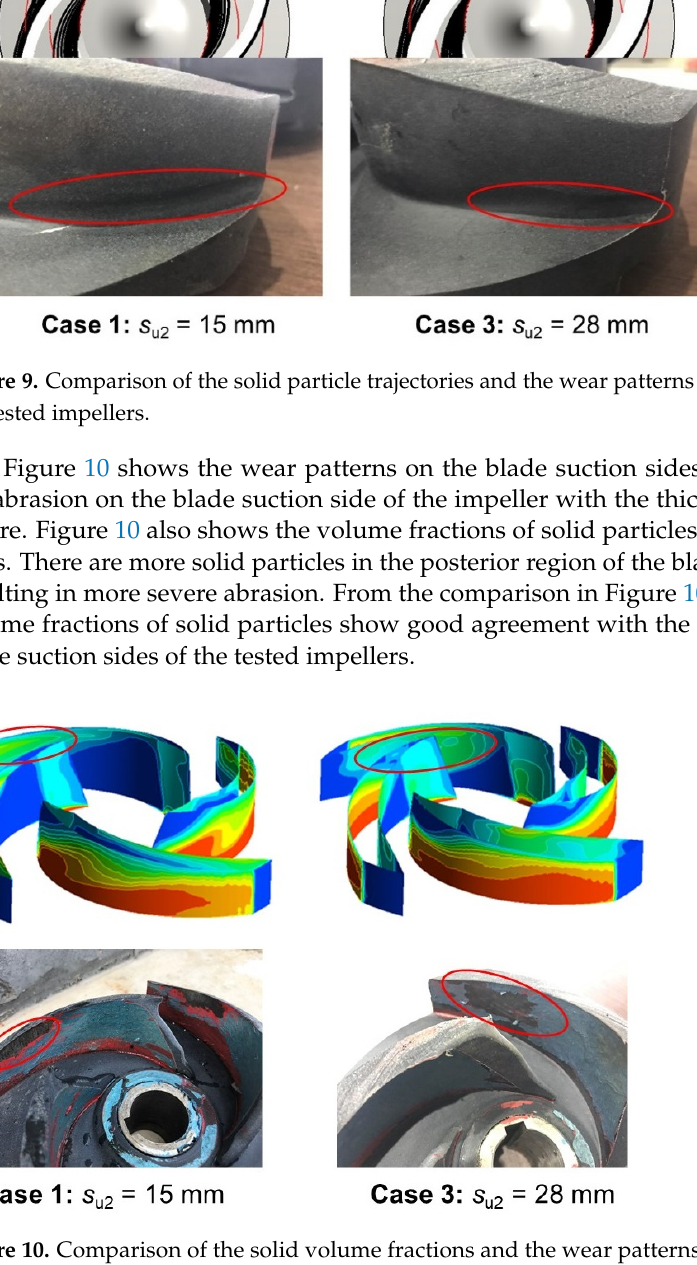
Figure 10. Comparison of the solid volume fractions and the wear patterns on the suction sides of the tested